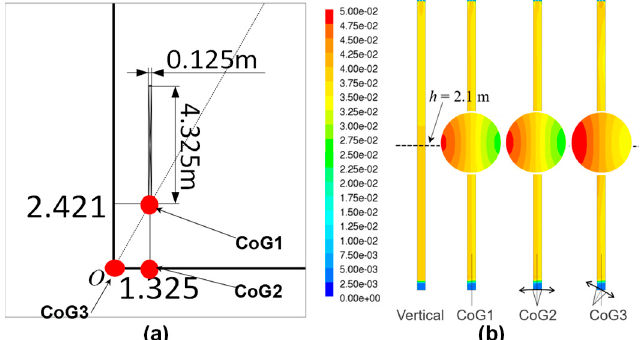
Figure 3. Amine absorber with structured-packing under off-shore operation. ( a ) Layout of amine absorber with three centers of gravity (CoG); and ( b ) liquid holdup contour under pitching motion at h = 2.1 m for three CoGs (modified from Kim et al. (2017) [75]).